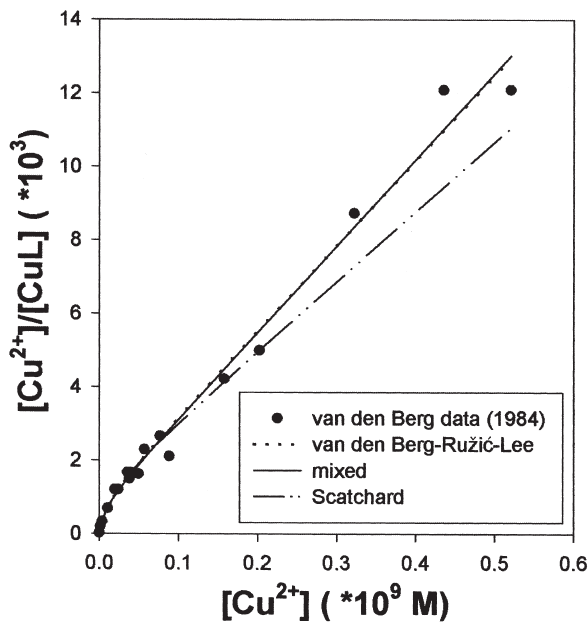
F IG . 3. – Van den Berg-Ruz ˇ ic´ linearising plot of the data set from van den Berg (1984). The lines correspond to three different itera- tive methods for resolving the complexing parameters for a two binding-site